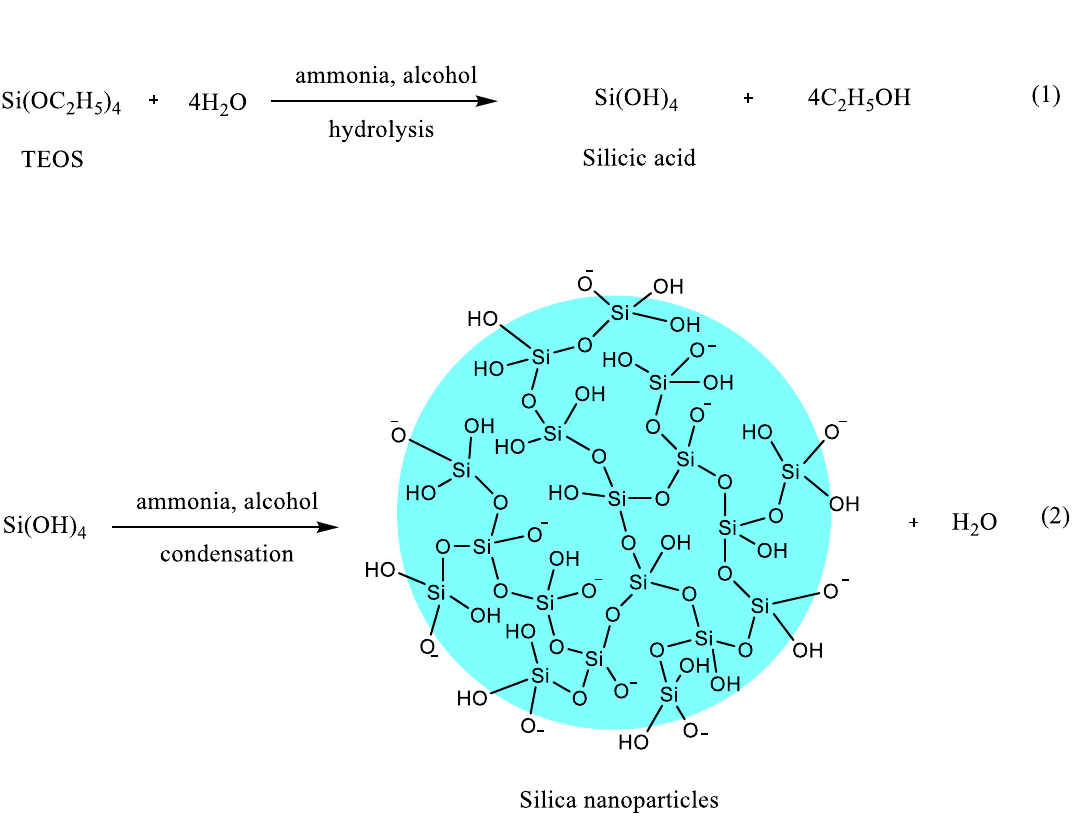
Figure 2. A reaction scheme showing the synthesis of silica nanoparticles from TEOS; Reaction (1) includes the hydrolysis of TEOS to form silicic acid, followed by reaction (2) which involves the condensation of the silicic acid to produce silica nanoparticles with siloxane bridges (Si-O-Si). Other silica sources, such as tetramethoxysilane (TMOS), tetrakis-2-hydroxyethylorthosilicate,